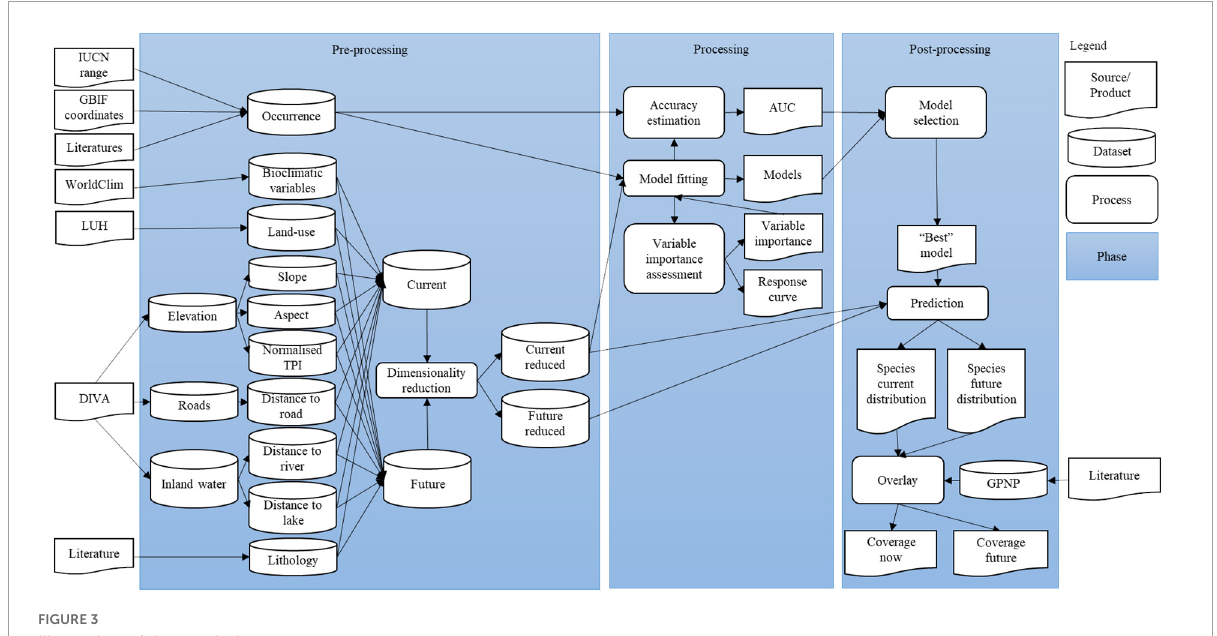
FIGURE3 Illustration of data analysis